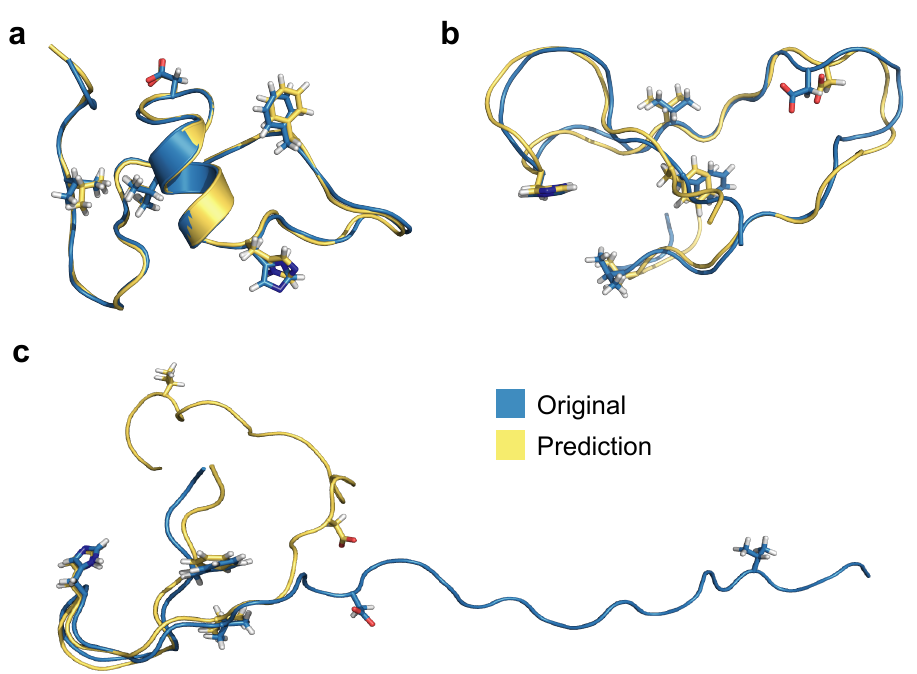
Figure 9. Alignment between original and predicted and processed 3D structures for ( a ) the best, ( b ) median, and ( c ) worst predictions based on RMSE values of